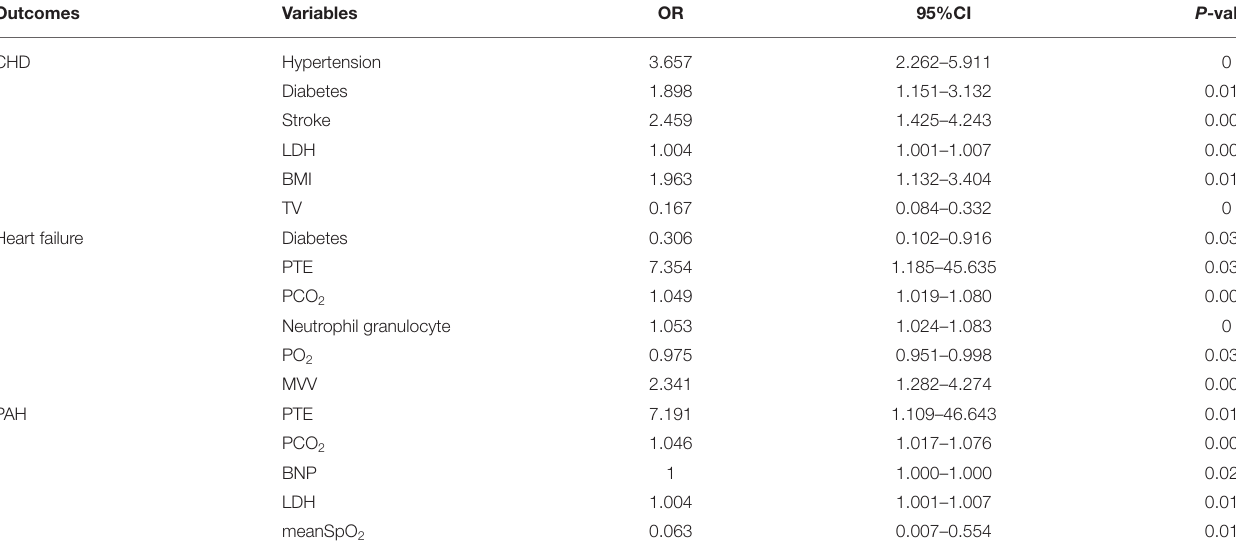
TABLE 5 | Results of logistic regression used to explore risk factors for cardiovascular events.